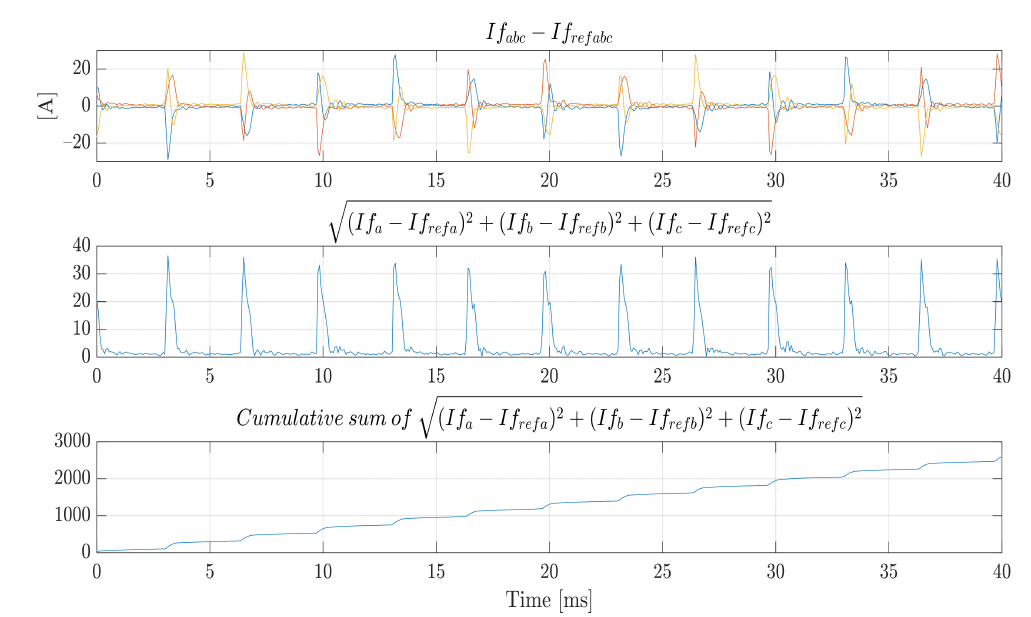
Figure 10. Error and quality factor of the PI controller.